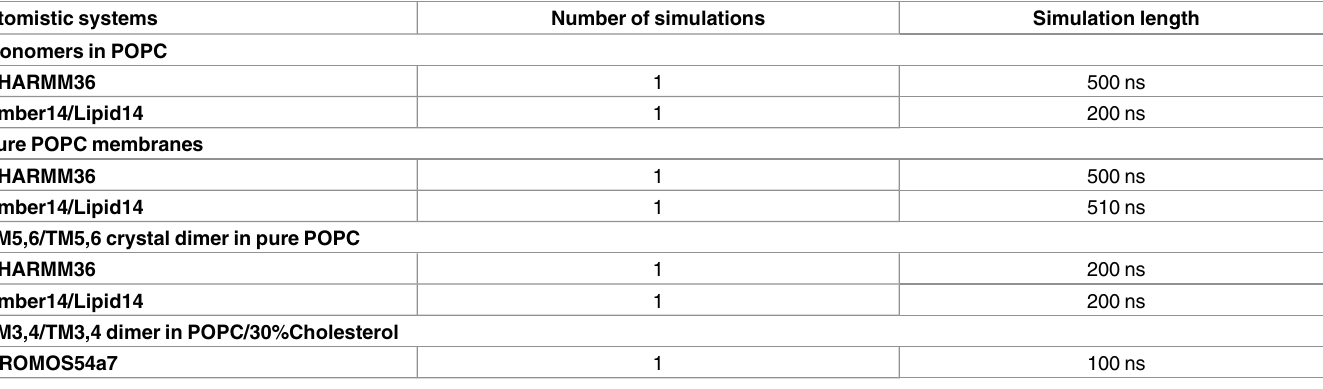
Table 2. Overview over all performed atomistic